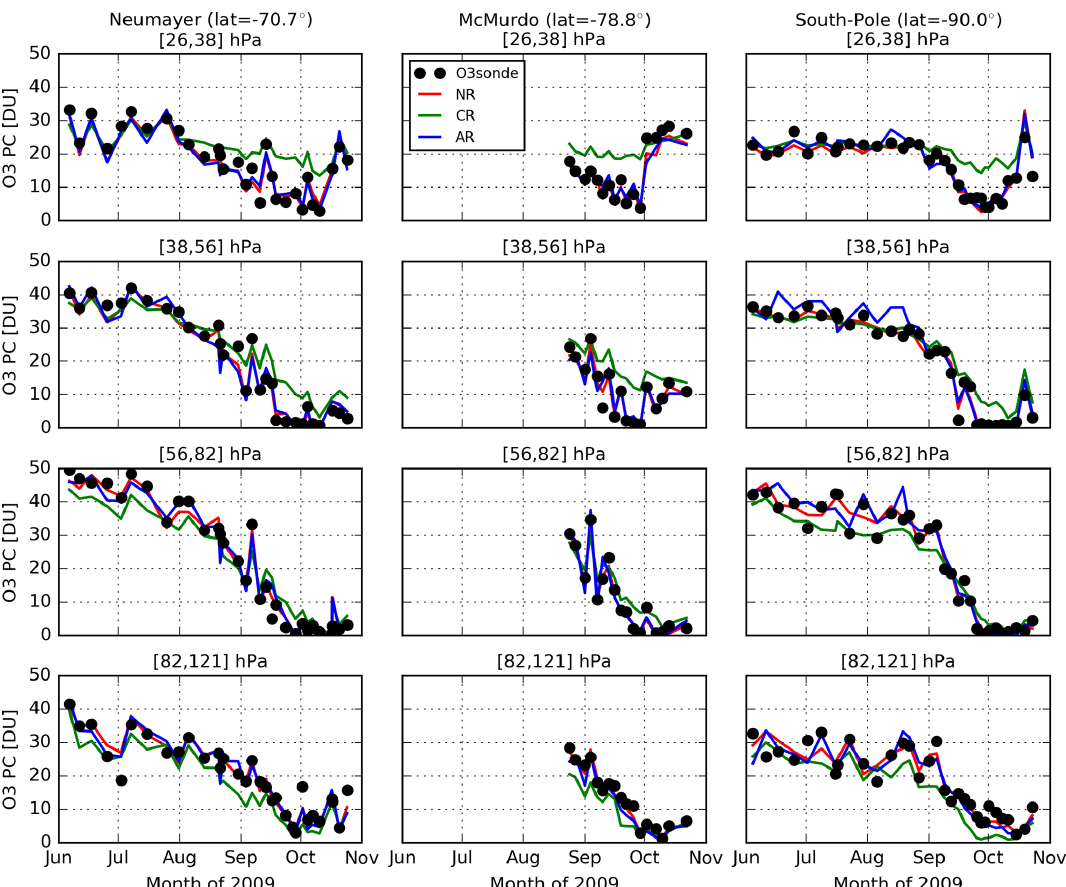
Figure 4. Time series of ozone partial column between June and October 2009 at four different pressure layers in the lower stratosphere and at three Antarctic NDACC stations from ozonesonde observations (black line), NR (red line), CR (green line) and AR (blue